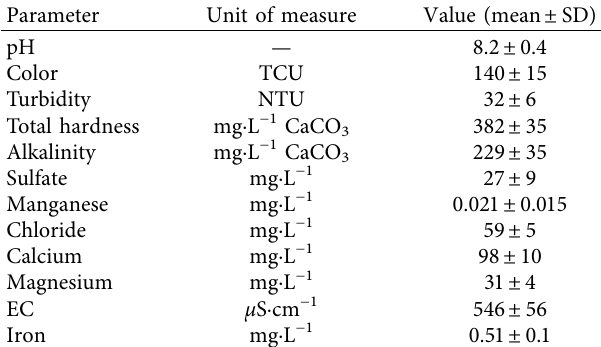
Table 1: Physical and chemical characteristics of wetland water. Parameter Unit of